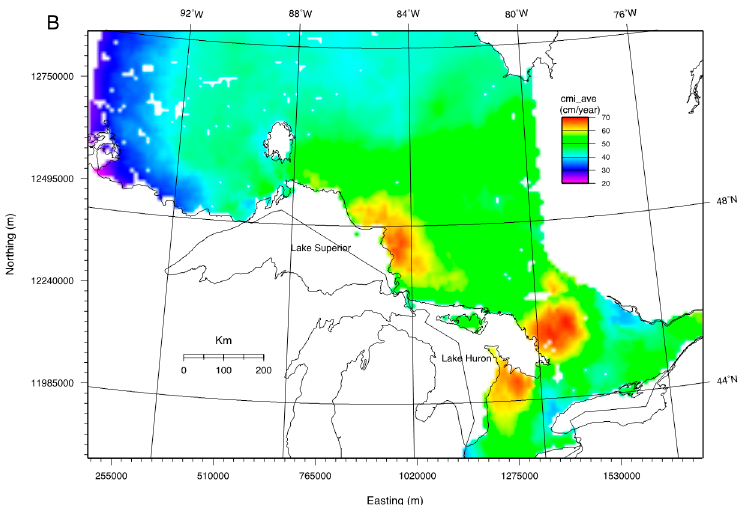
Figure 1. ( A ) Frequency (number of years) of moderate to severe defoliation by spruce budworm between 1941 and 2005 on a 10-km grid; ( B ) Average climate moisture index (cm/year) between 1 November and 31 October on a 10-km grid from 1941 to 2003. (See text for calculating algorithm).